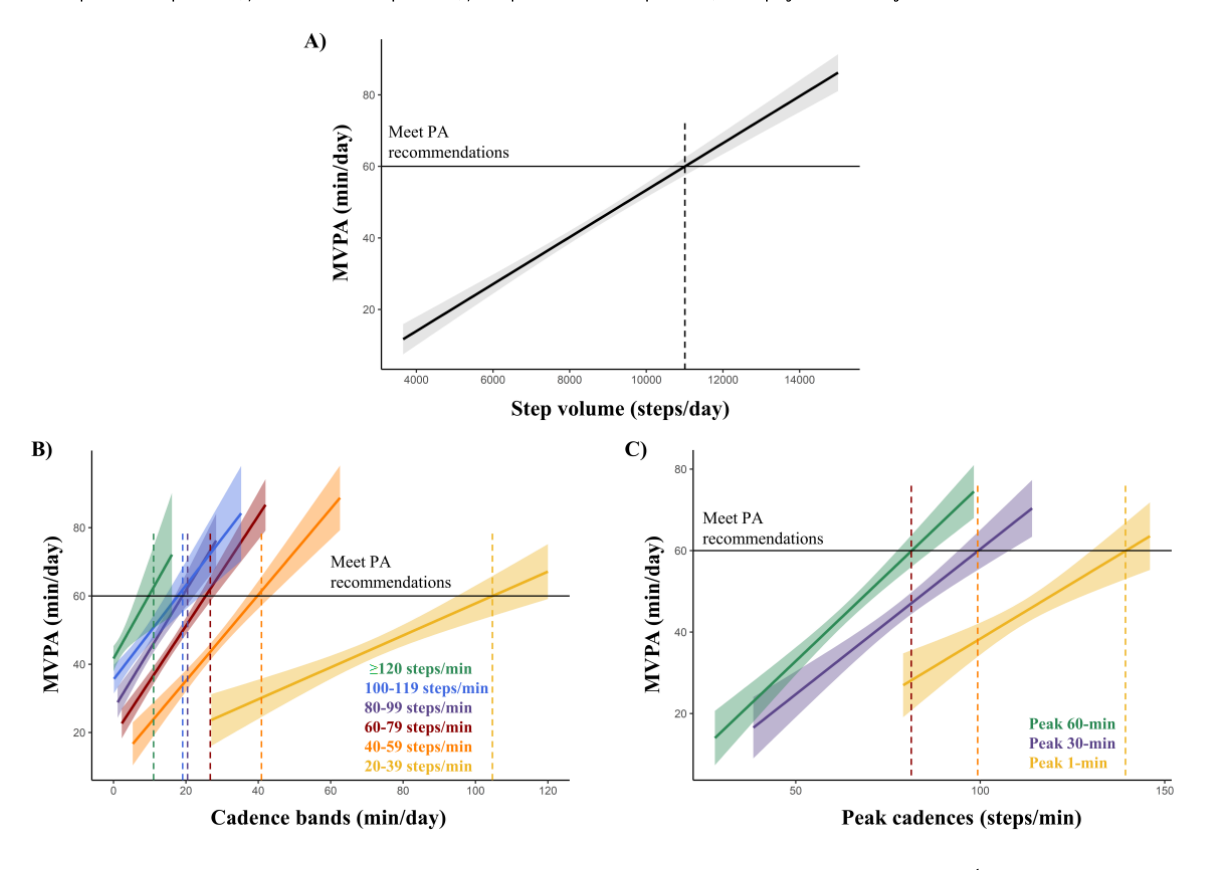
Figure 4. Linear regression line, with 95% CI (shaded areas), for the association between moderate-to-vigorous physical activity (MVPA) and